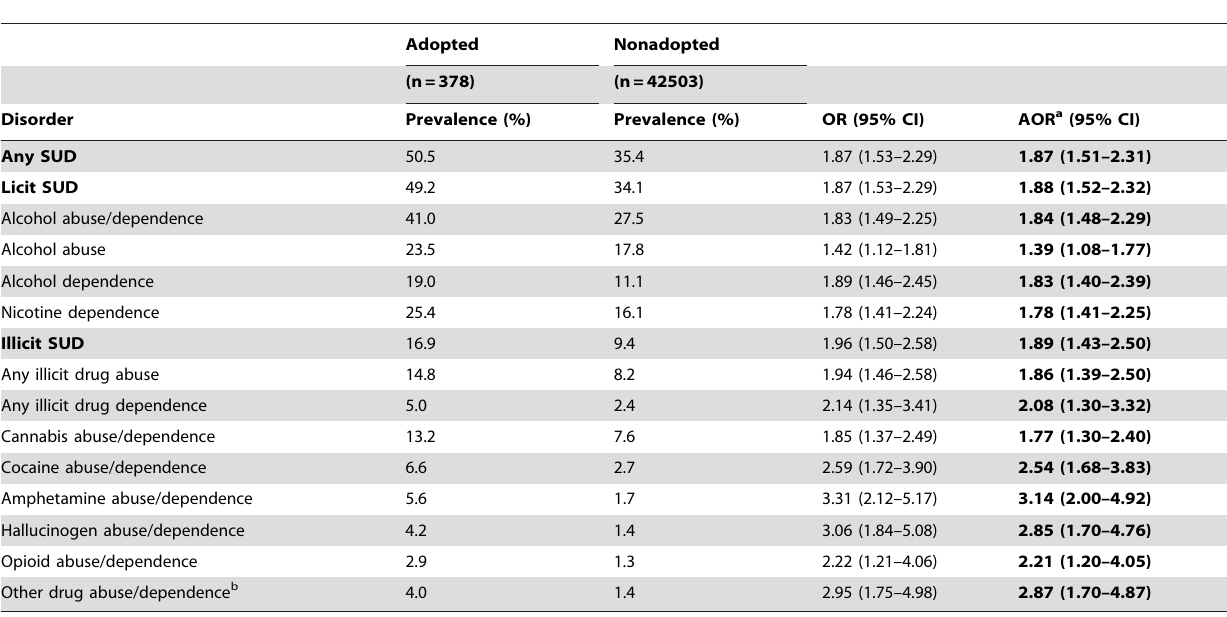
Table 2. Prevalence rates and adjusted odds ratios of lifetime SUDs in adopted and nonadopted